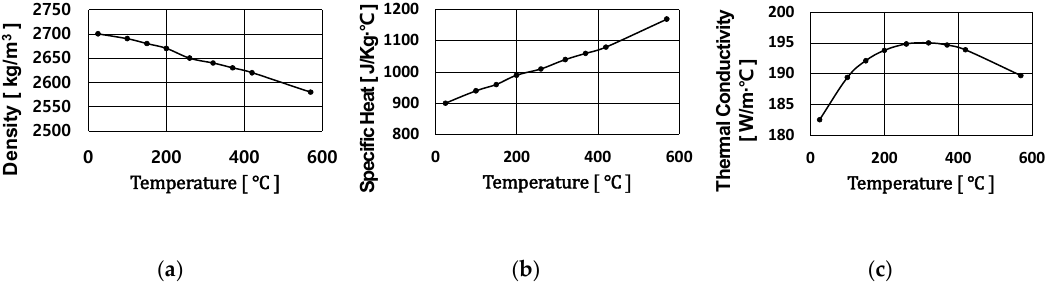
Figure 12. AL6063-T5 material properties required for heat transfer analysis: ( a ) Density; ( b ) specific heat; ( c ) thermal conductivity.